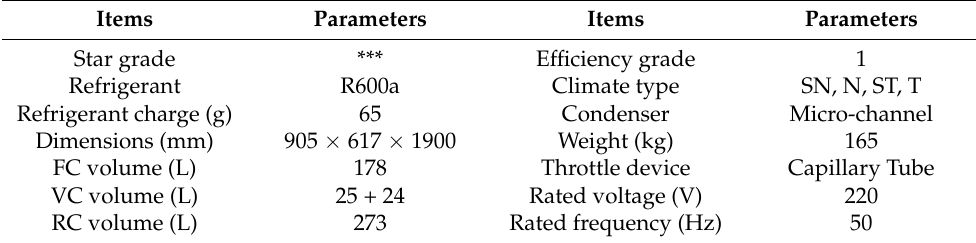
Table 1. The main technical parameters of the tested frost-free refrigerator.